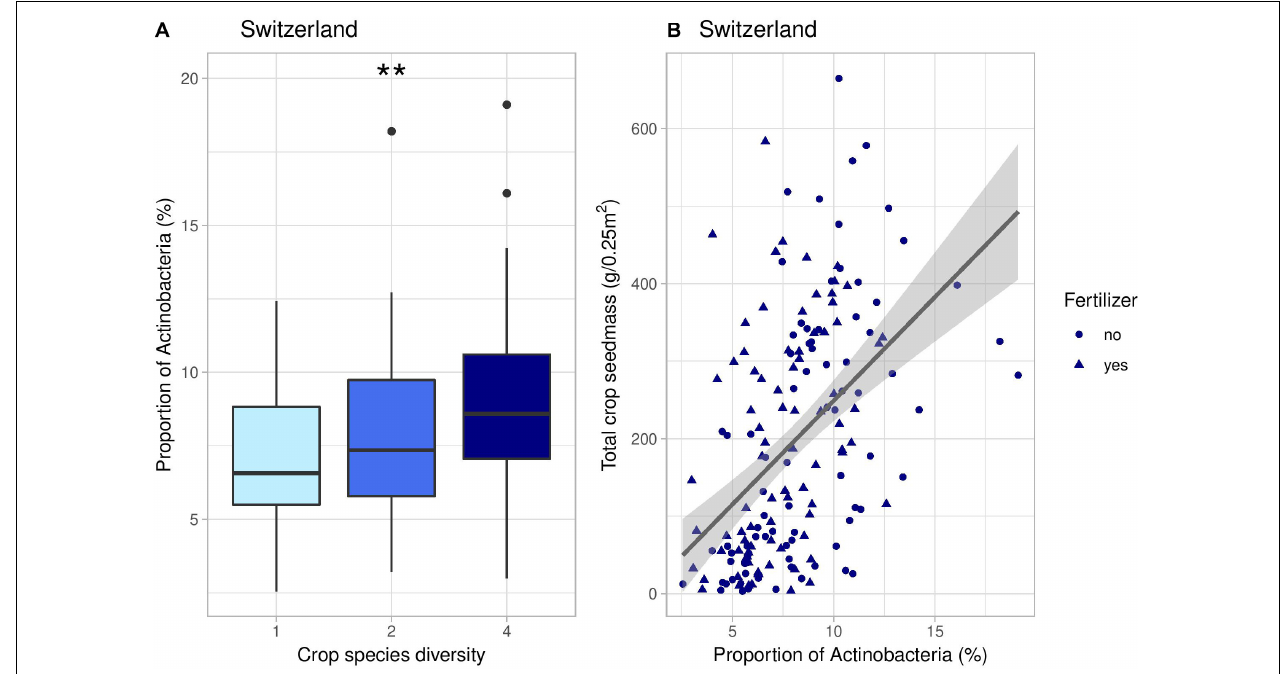
FIGURE 6 | Effects of crop species number on the proportion of Actinobacteria (A) and correlation between the proportion of Actinobacteria and total crop yield (B) in Switzerland. In panel (B) , the line represents the linear regression (coefficient: 26.8, p -value < 0.001). **indicates the significance level of the effects of crop species number on bacterial PCoA 2 ( p -value <